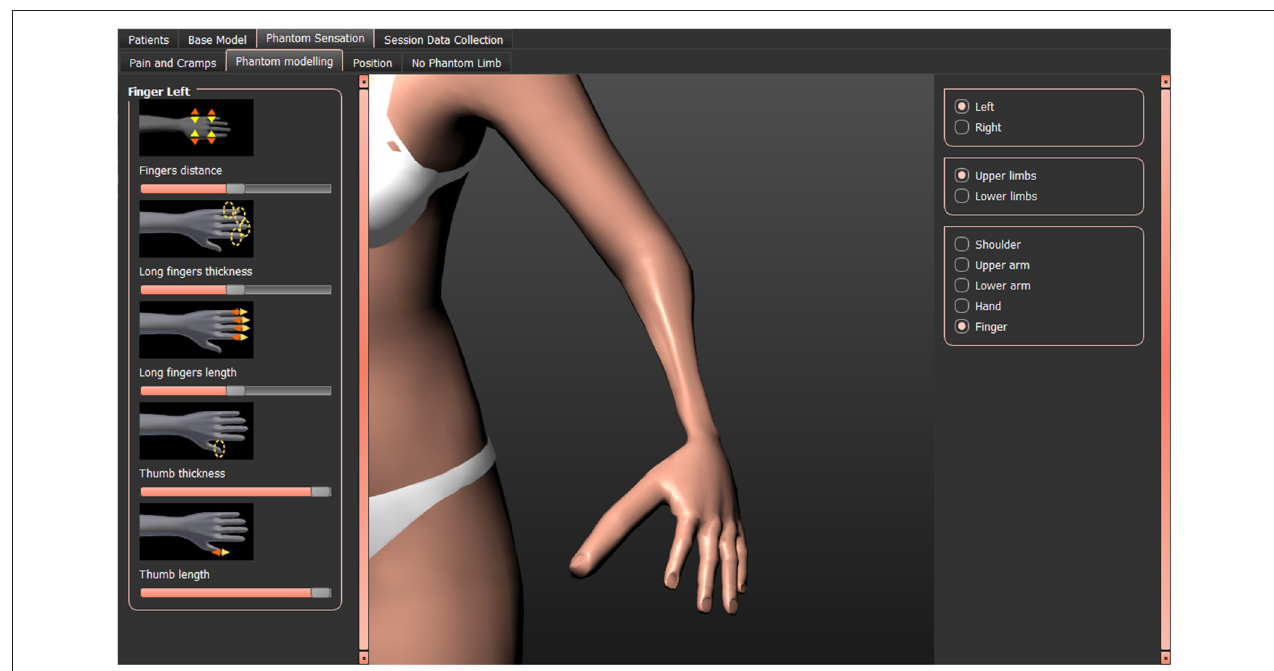
FIGURE 1 | Adjusting the shape of the phantom limb by decreasing the thickness of the lower arm and increasing length and thickness of the thumb.